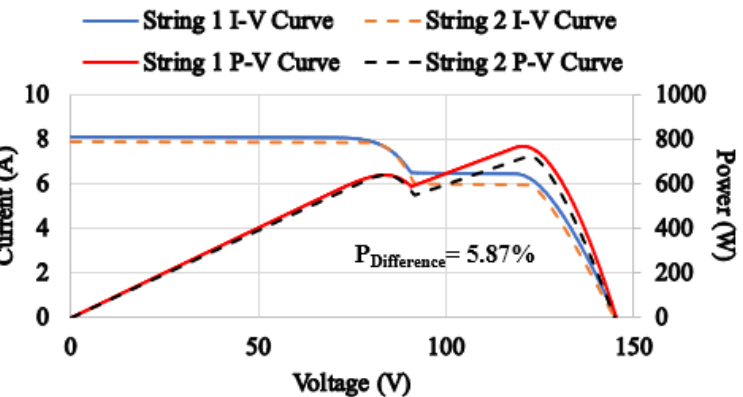
Figure 6. Inspection of the PV modules on after three years of field service, the measured P-V and I-V curves for both PV strings at 827 W/m 2 solar irradiance and a PV surface temperature of 23.3 °C.